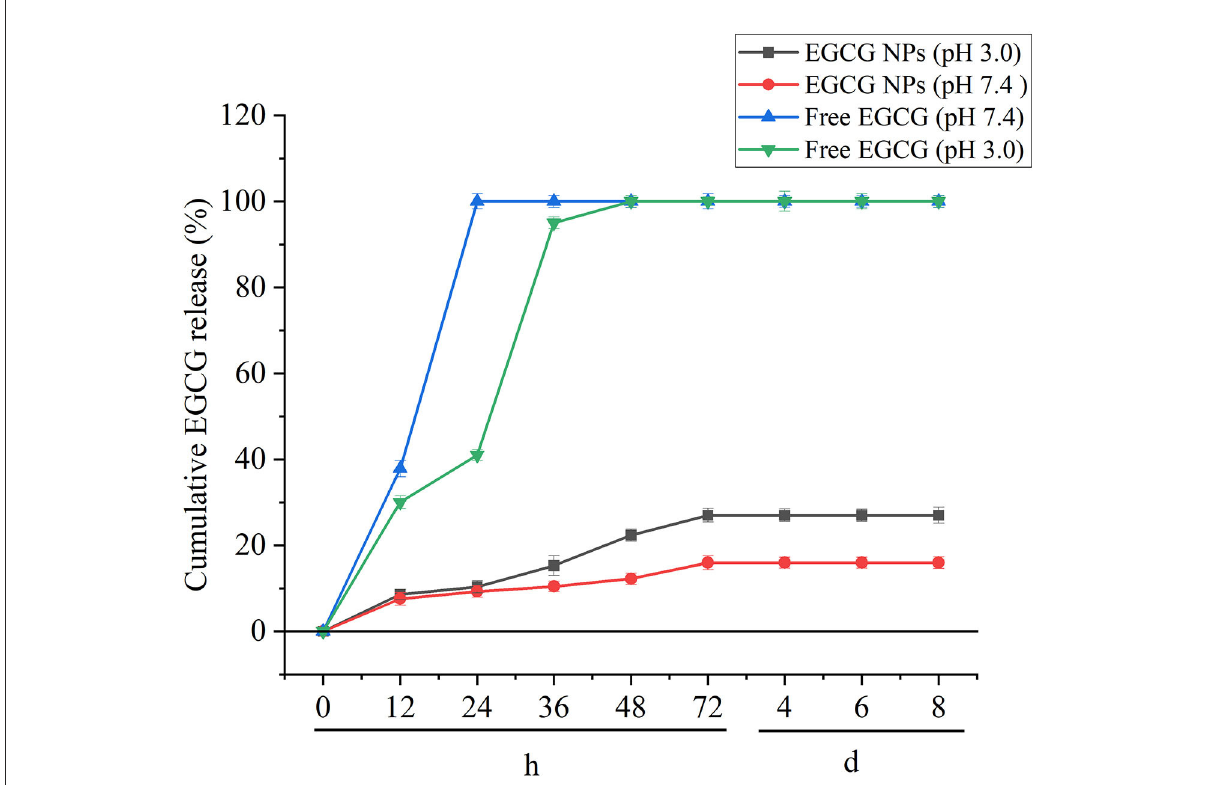
FIGURE3 In vitro EGCG release profile of free EGCG and EGCG-NPs in pH 3.0 and pH 7.4 buffers. Data are expressed as mean ± SD ( n = 3).